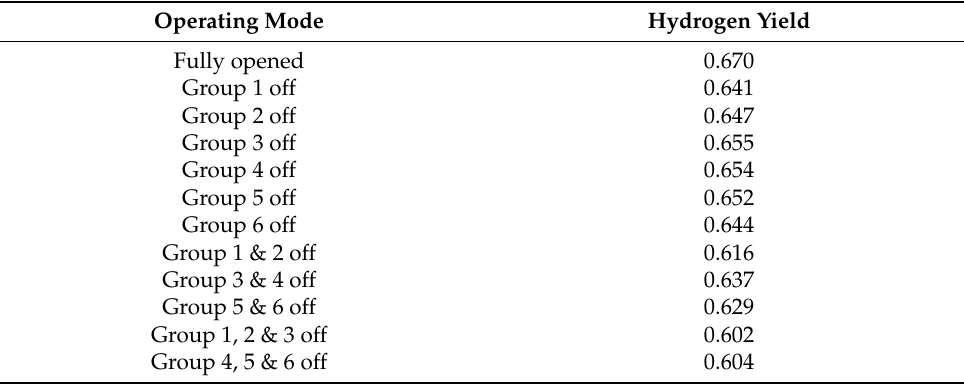
Table 2. Average hydrogen yields using different burners on/off combinations.